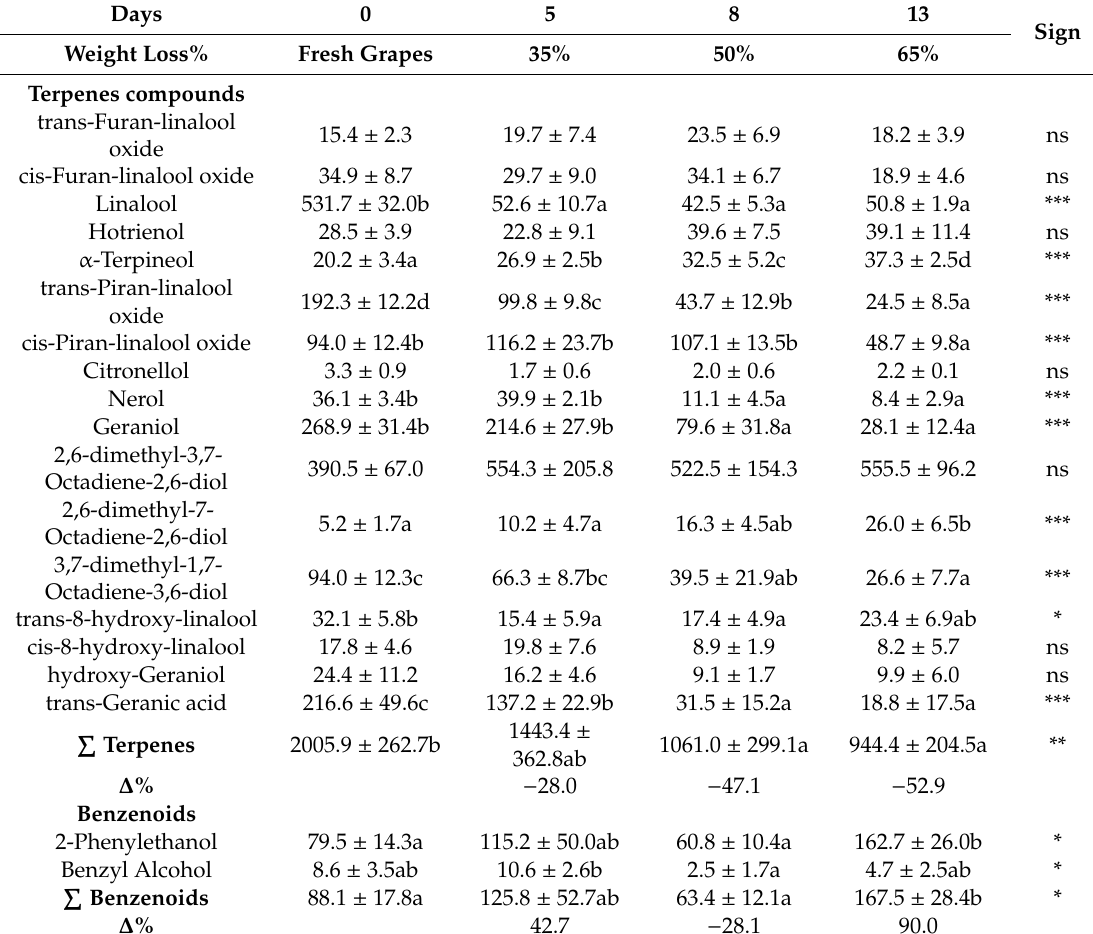
Table 2. Evolution of free volatile compounds of Muscat Alexandria grapes during dehydration ( µ g / 100